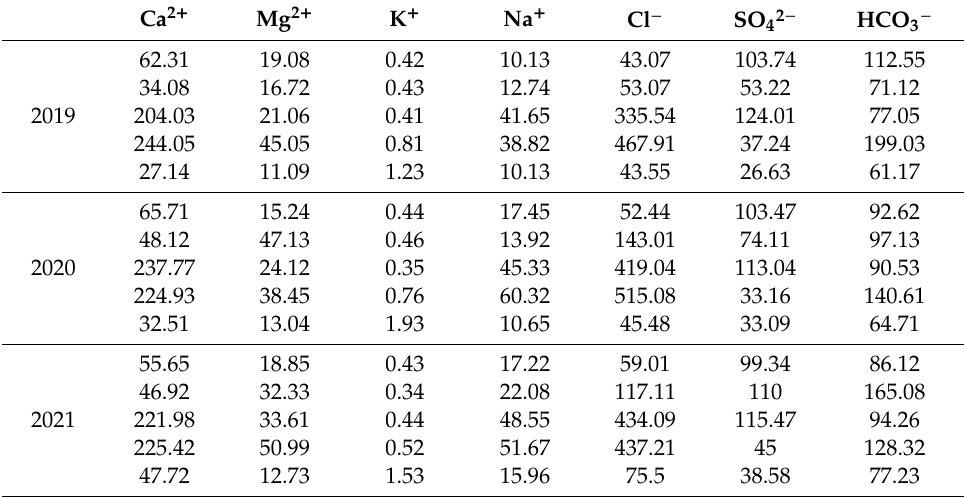
Table 5. Forecast of groundwater hydro-chemical data during